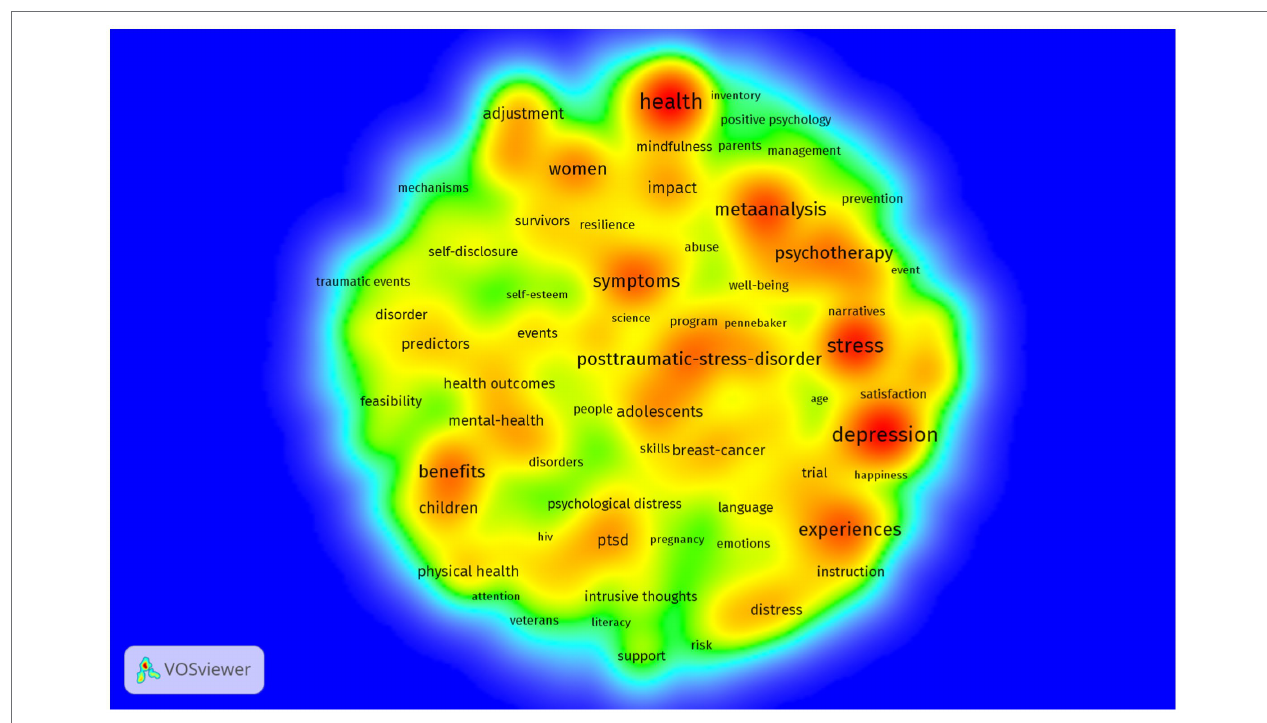
FIGURE 6 | Heat map of density visualization of keywords co-occurrence network. Visualization scale weights were based on total link strength. Layout setting: attraction = 5, repulsion = − 6. The area in red represents higher frequency of related keywords, the yellow or red-yellow areas suggesting less heated keywords discussed by scholars and the green areas representing even less density and lower degree of heat in